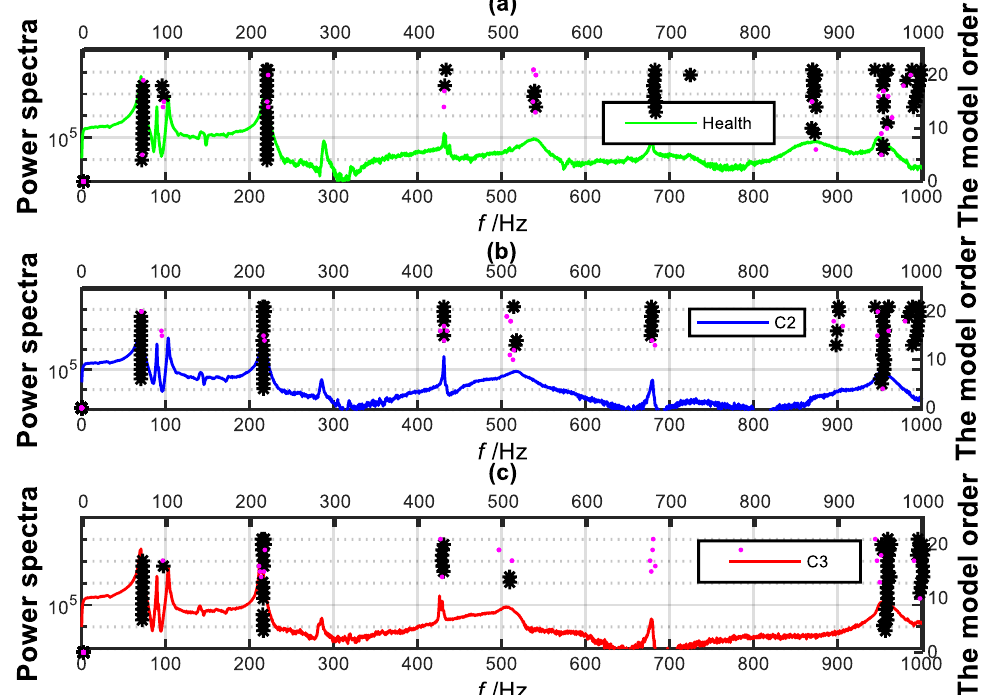
Figure 9. The configuration of the hydraulic pipeline test rig.